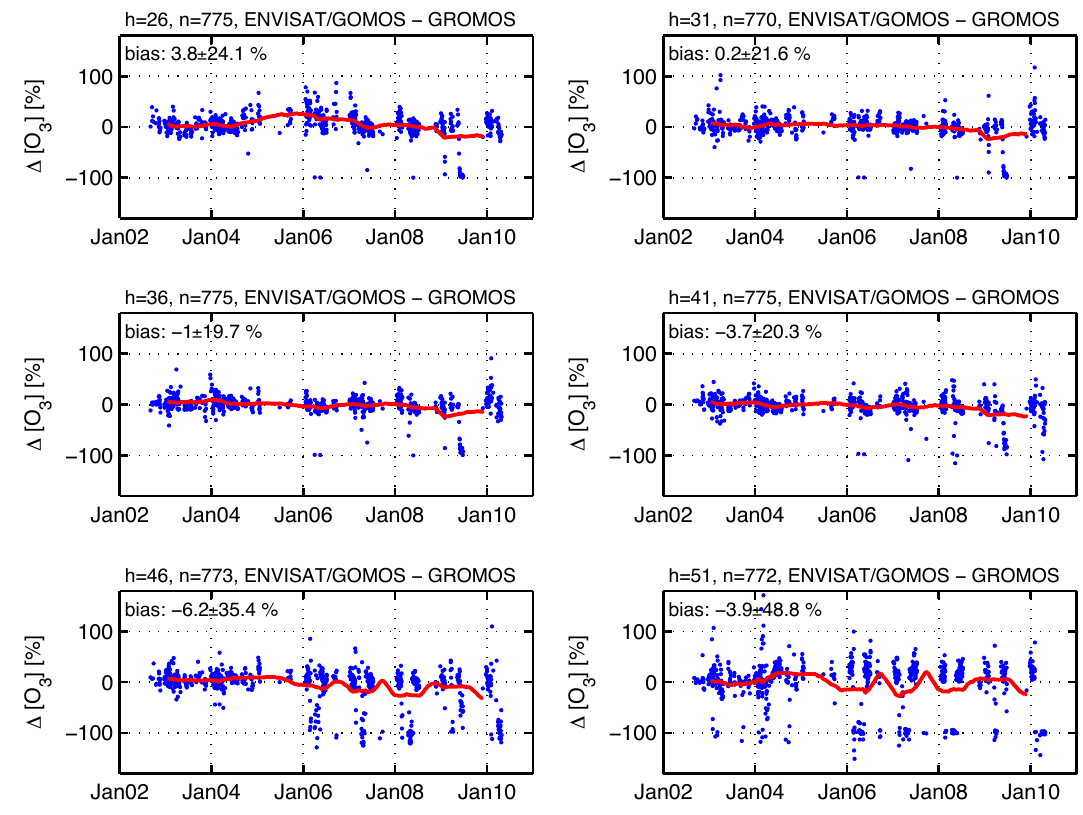
Fig. 7. Time series of the relative difference 1 O 3 of the ozone concentration profiles of GOMOS and the ground-based microwave radiometer GROMOS at altitudes h = 26 , 31 , 36 , 41 , 46, and 51km. The red line is a moving average over 80 blue dots. Sometimes GOMOS fails to detect ozone at upper altitudes (more frequently at h = 46 and 51km with 1 O 3 values close to − 100%). N corresponds to the number of